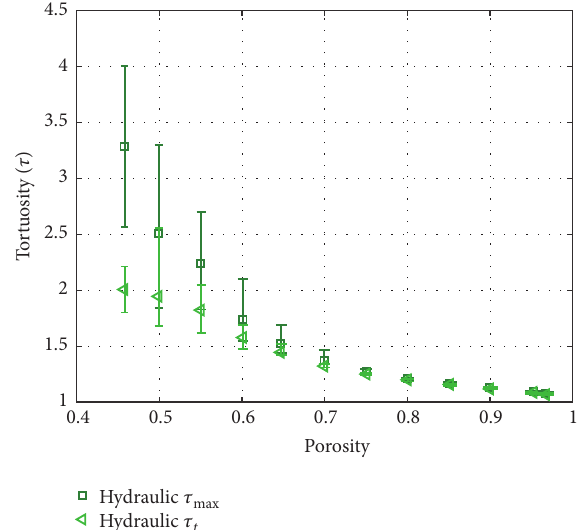
Figure 18: Hydraulic tortuosity-porosity trend for randomly dis- tributed squares. The flow pathways are more tortuous as geometry is comprised of more solid squares (i.e., lower porosity).